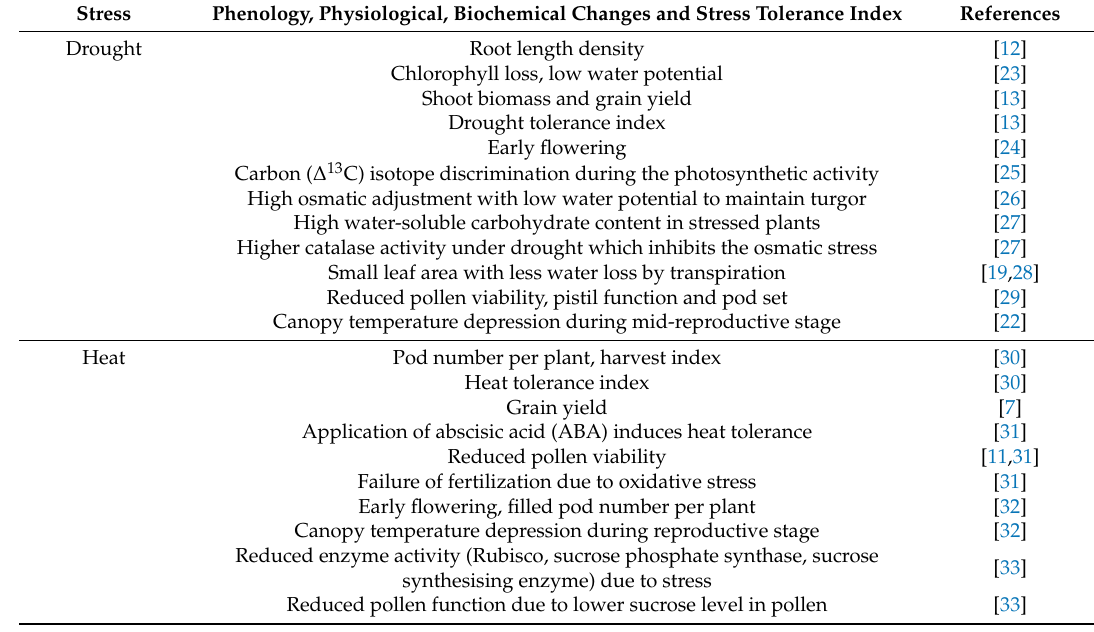
Table 1. Mechanism of phenology, physiological and biochemical changes in drought and heat tolerance in